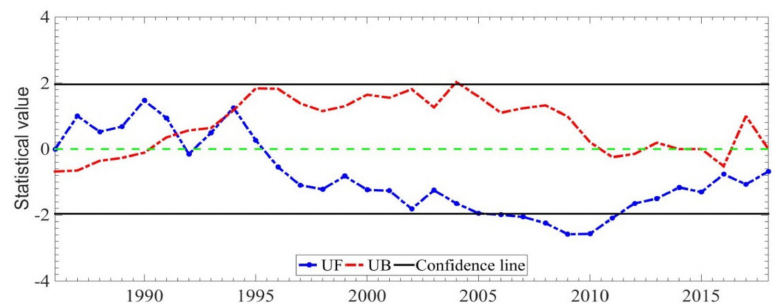
Figure 8. The trend of total annual precipitation at the Ugii Nuur Lake site (where UF and UB are parameters of the change, UB = −